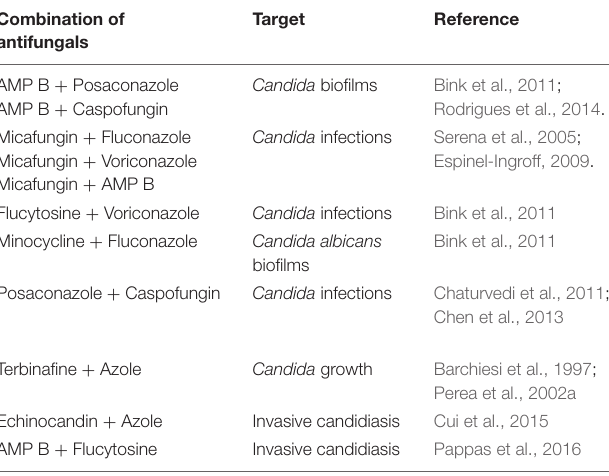
TABLE 1 | Various regimes of combinatorial antifungal therapy showing better efficacy in combination than that of independent drugs. Combination of